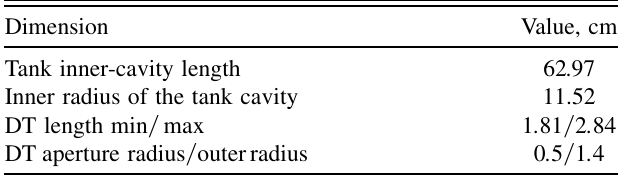
TABLE IV. Dimensions of IH1 tank.